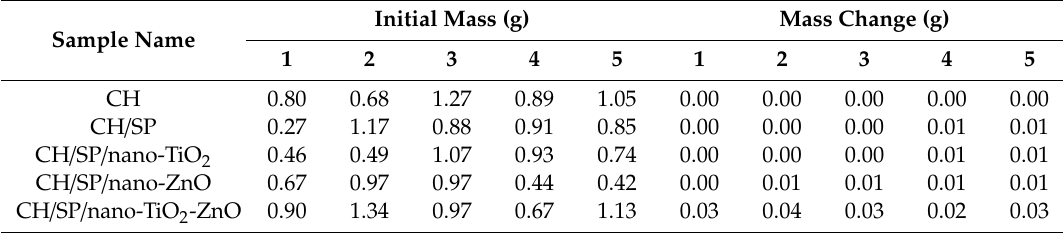
Table 2. Initial mass and mass change after treatment of coated wood sample.